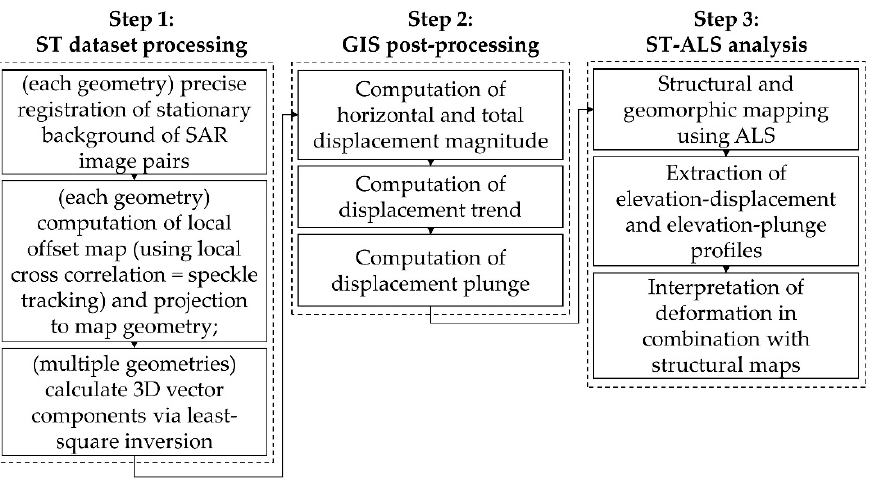
Figure 2. Flowchart of the proposed speckle track SAR-GIS-ALS